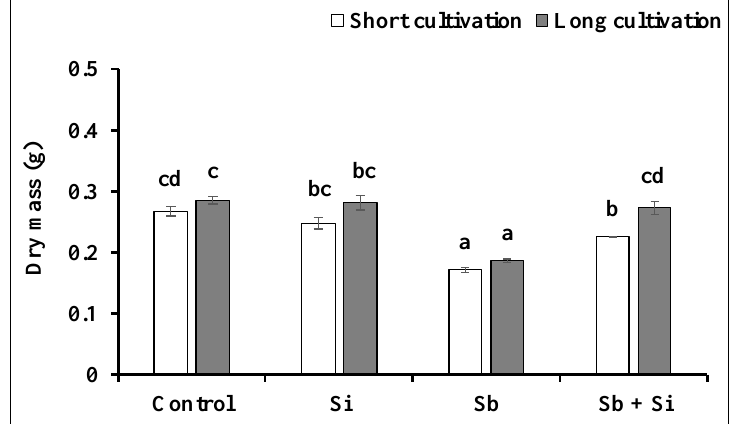
Figure 5. Dry mass (g) of the poplar calli after the short and long cultivations. The data are presented as the means ± standard error ( n = 30). Control — basal medium; Si treatment — basal medium + Si (5 mM); Sb treatment — basal medium + Sb (0.2 mM); Sb + Si treatment — basal medium + Sb (0.2 mM) and Si (5 mM). Different letters above bars denote statistically significant differences in the parameters between the treatments at p < 0.05 according to the Tukey